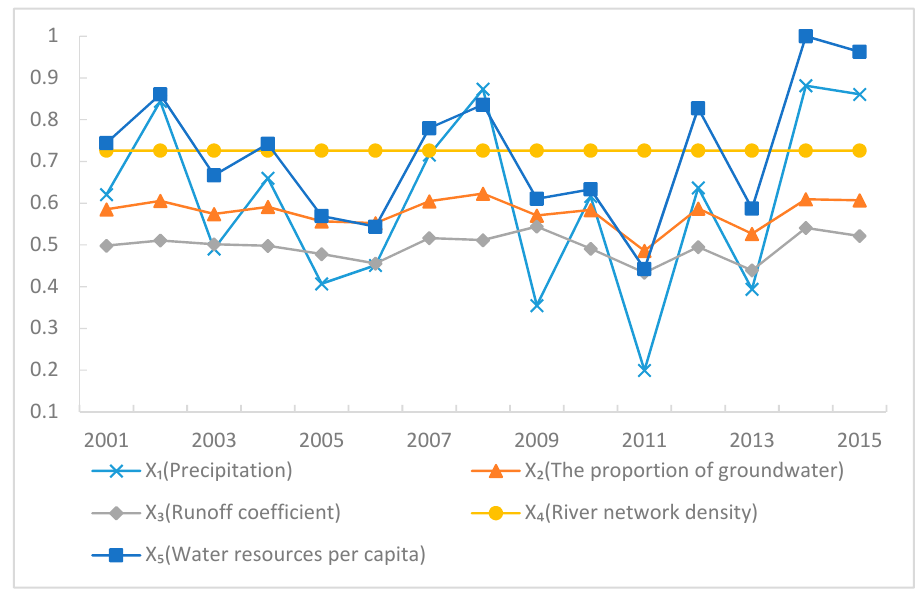
Figure 4. Changes in WRBC (Water Resources Background Conditions) indicators of Guizhou Province in